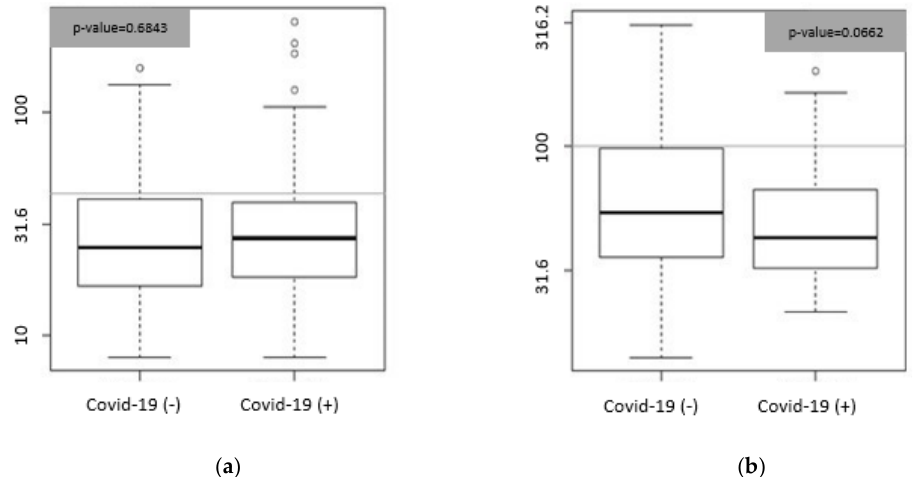
Figure 1. ( a ) Box plot. Concentrations expressed in pg/mL of Bio-ADM in the COVID– ( n = 52) and COVID+ group ( n = 101)) at T0. Gray lines represent the 99th percentile of normal values (43 pg/mL); black lines represent median values (COVID − = 24.8; COVID+ = 27.3). ( b ) Box plot. Concentrations expressed in pmol/L of penKid in the COVID − ( n = 52) and COVID+ group ( n = 101). Gray lines represent the 99th percentile of normal values (100 pmol/L); black lines represent median values (COVID − = 54.14; COVID+ = 43).